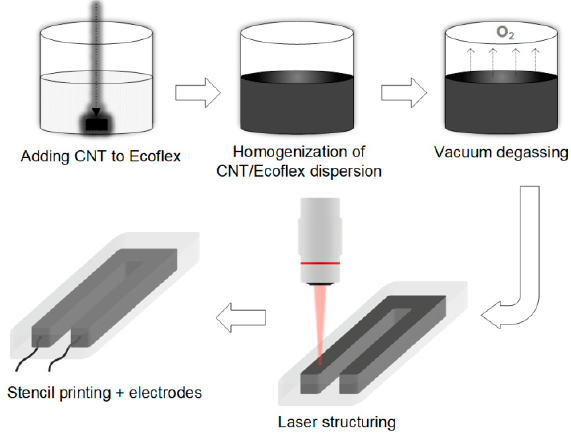
Figure 1. Strain-sensitive material manufacturing